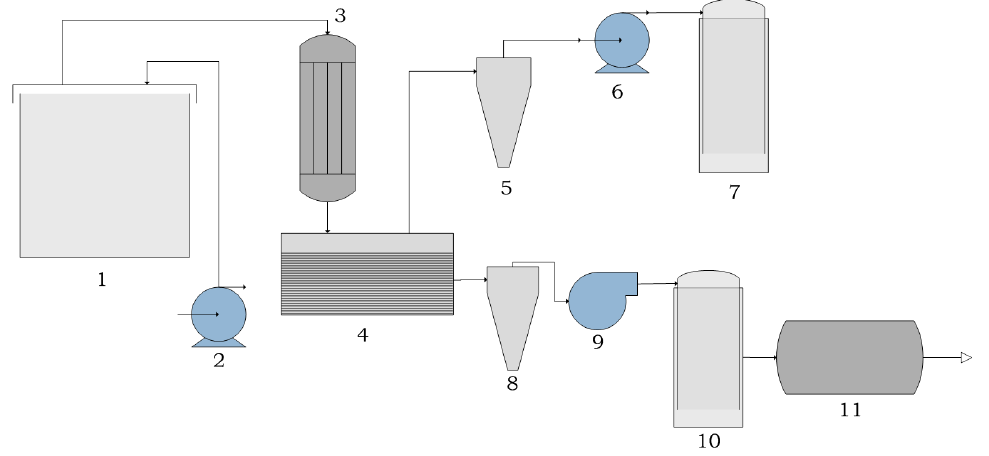
Figure 1. Schematic diagram of a reactor line for oil sludge disposal, where: 1—type 1 pyrolysis reactor; 2, 6—pump; 3—refrigerator; 4—mud tank; 5—liquid product rectifier; 7—receiver; 8—gaseous product rectifier; 9—fan; 10—gas tank; 11—type 2 pyrolysis reactor.